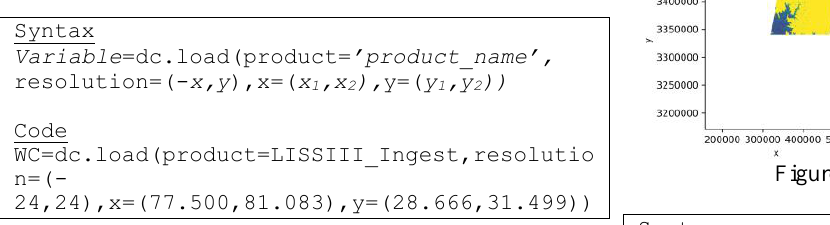
Figure 8. NO_DATA